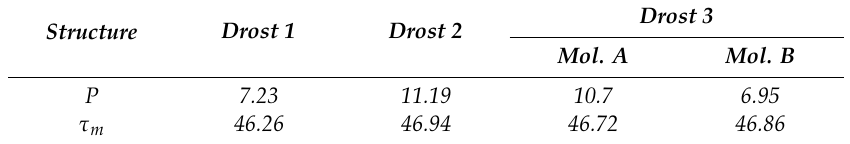
Table 8. Pseudo ‐ rotation and maximum torsion angles in D rings (Degree). Table 8. Pseudo-rotation and maximum torsion angles in D rings (Degree).